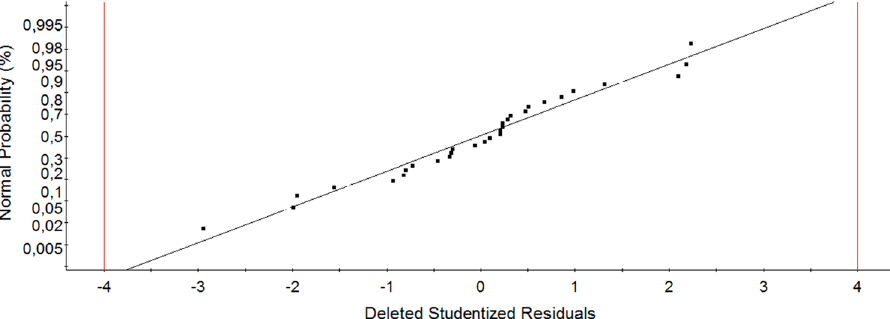
Fig. 5 Normal probability plots of residuals for % removal of AB25